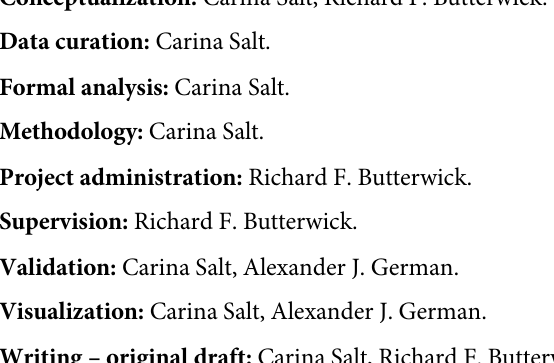
S1 Table. Estimated means and 95% credible intervals for the values at each timepoint, the fold change from 10wk-old and the difference in the fold change between groups for all